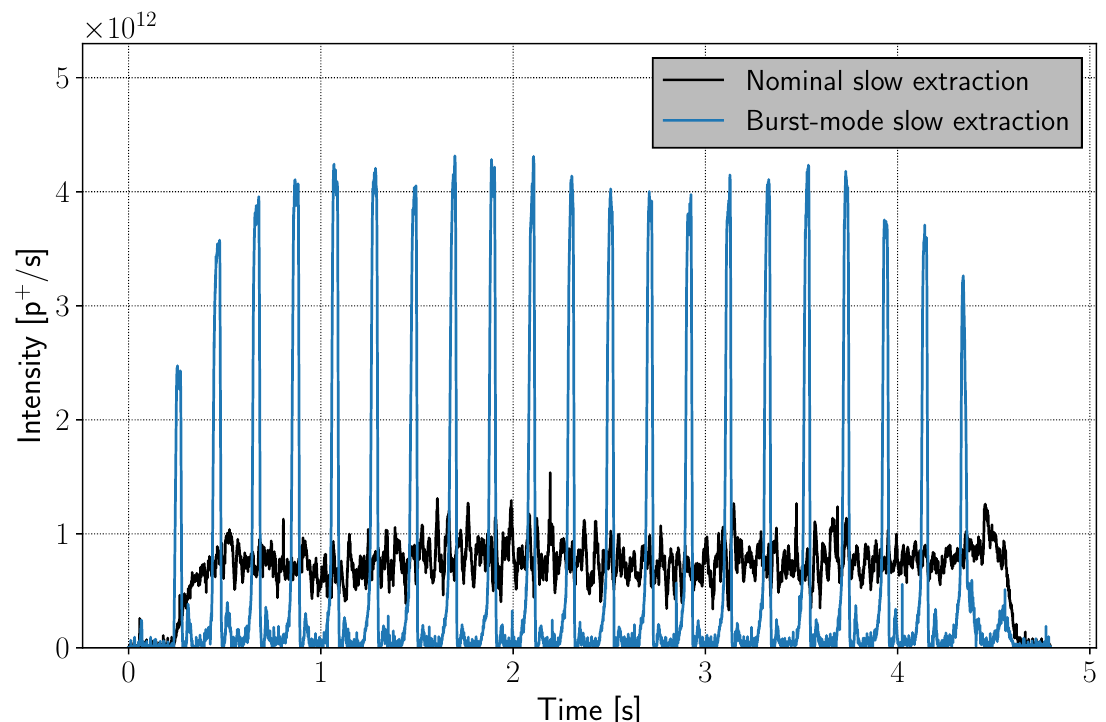
Figure 3. Comparison between a nominal slow extracted spill and a “burst-mode slow extraction” one. The spill profiles have been measured with a secondary emission monitor at the SPS, during dedicated machine tests. The same intensity is extracted in the two